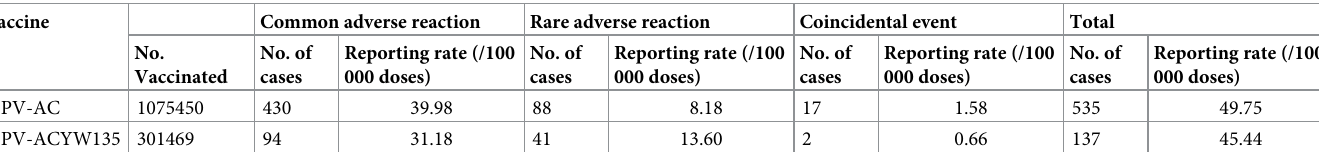
Table 4. AEFI incidence of MPV-AC and MPV-ACYW135 vaccinated from 2014 to 2019.